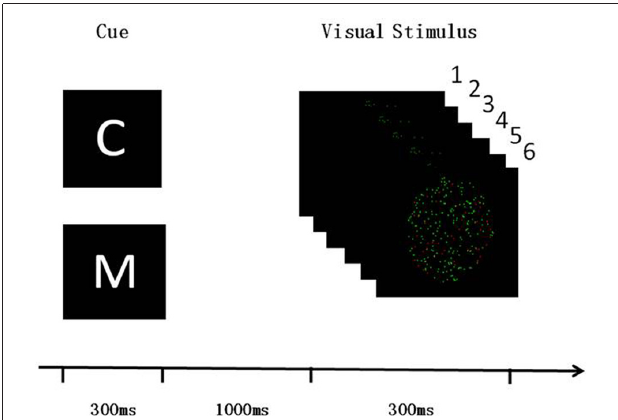
FIGURE 1 | Visual feature-based attention (FBA) task paradigm. Both of the experiment 1 and the experiment 2 used the same design paradigm. Subjects needed to discriminate either the color or the direction of moving for most of dots in the visual stimulus dynamic pictures. C and M cues indicated color and motion discrimination, respectively. The stimulus onset asynchrony between the cue and visual stimulus was 1,000 ms, and the screen kept black during this